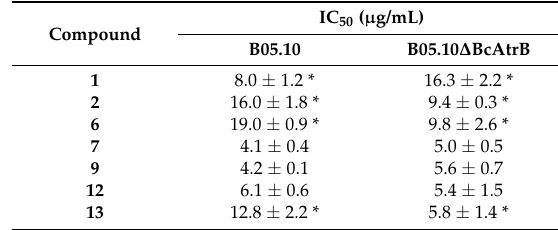
Table 1. Effect of compounds 1 , 2 , 6 , 7 , 9 , 12 , and 13 on the mycelial growth of B05.10 and B05.10 ∆ BcatrB strains.